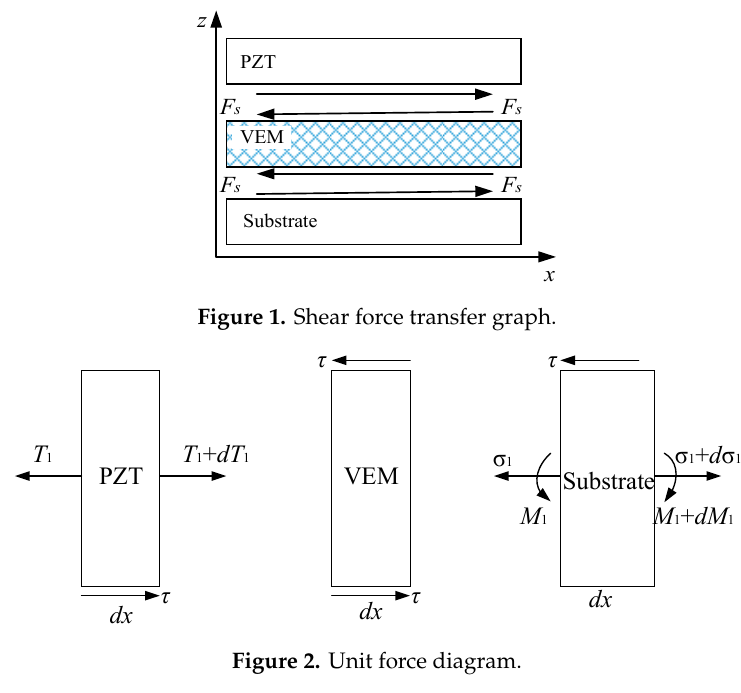
Figure 2. Unit force diagram.